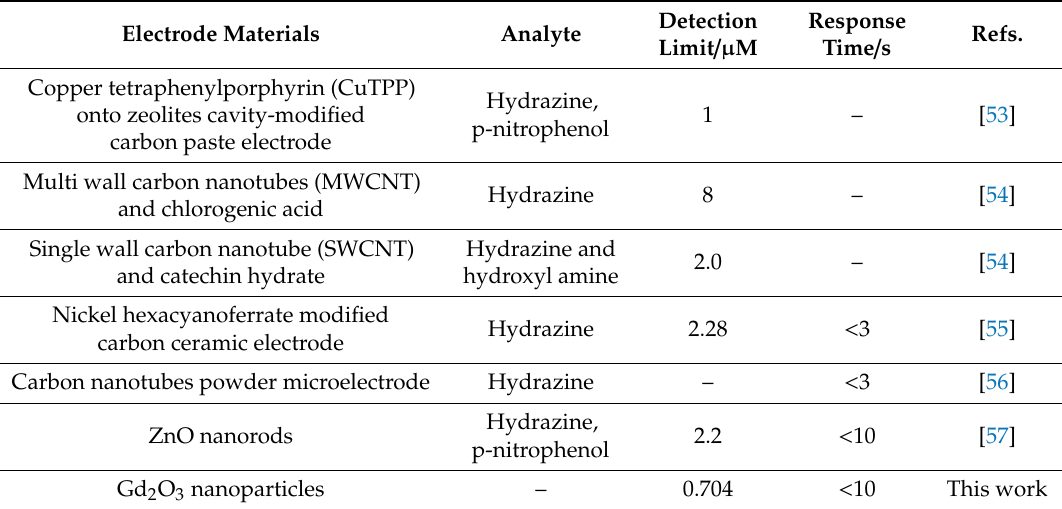
Table 1. Comparison of detection limit and response time of di ff erent electrode